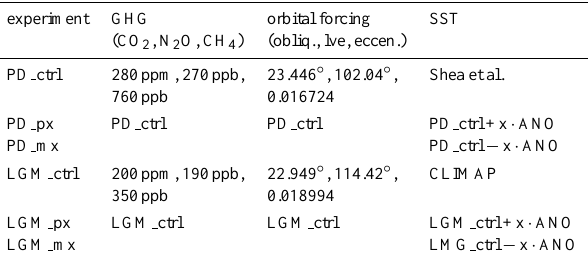
Table 1. Experiment summary, x is the strength factor used to mul- tiply the anomaly ( x =0.5, 1, 1.5, 2), ANO – anomaly from ECBilt- CLIO